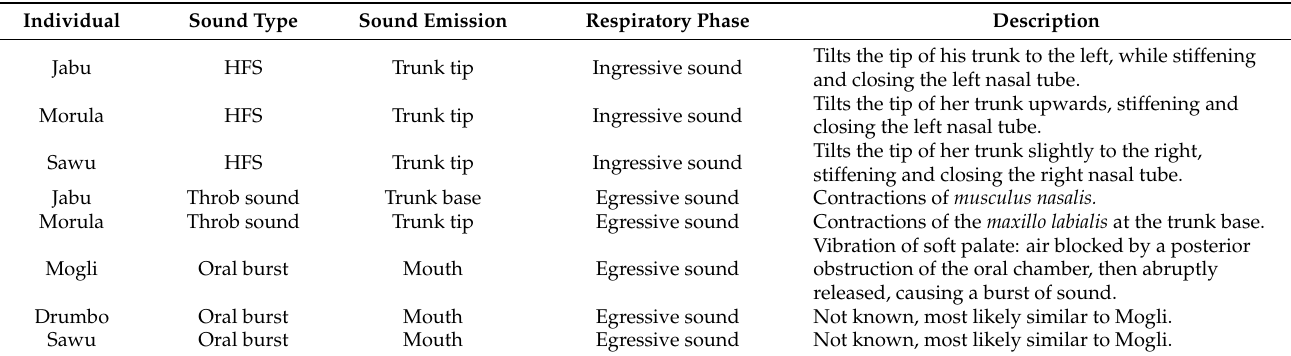
Table 2. Idiosyncratic sounds and variation of sound production in individuals.